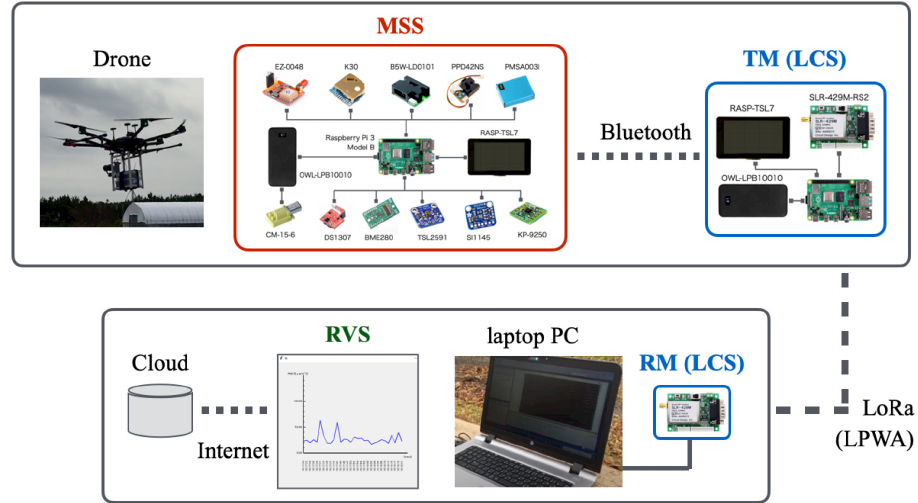
Figure 1. Overall architecture of our proposed system for in situ atmospheric measurements. An LCS comprises two modules: a transmitter module (TM) and a receiver module (RM). The MSS and TM are mounted on a drone for remotely measuring atmospheric phenomena over a wide area. Together, the MSS and LCS are independent hardware. They communicate using Bluetooth: a short-range, low-power, and low-cost communication protocol